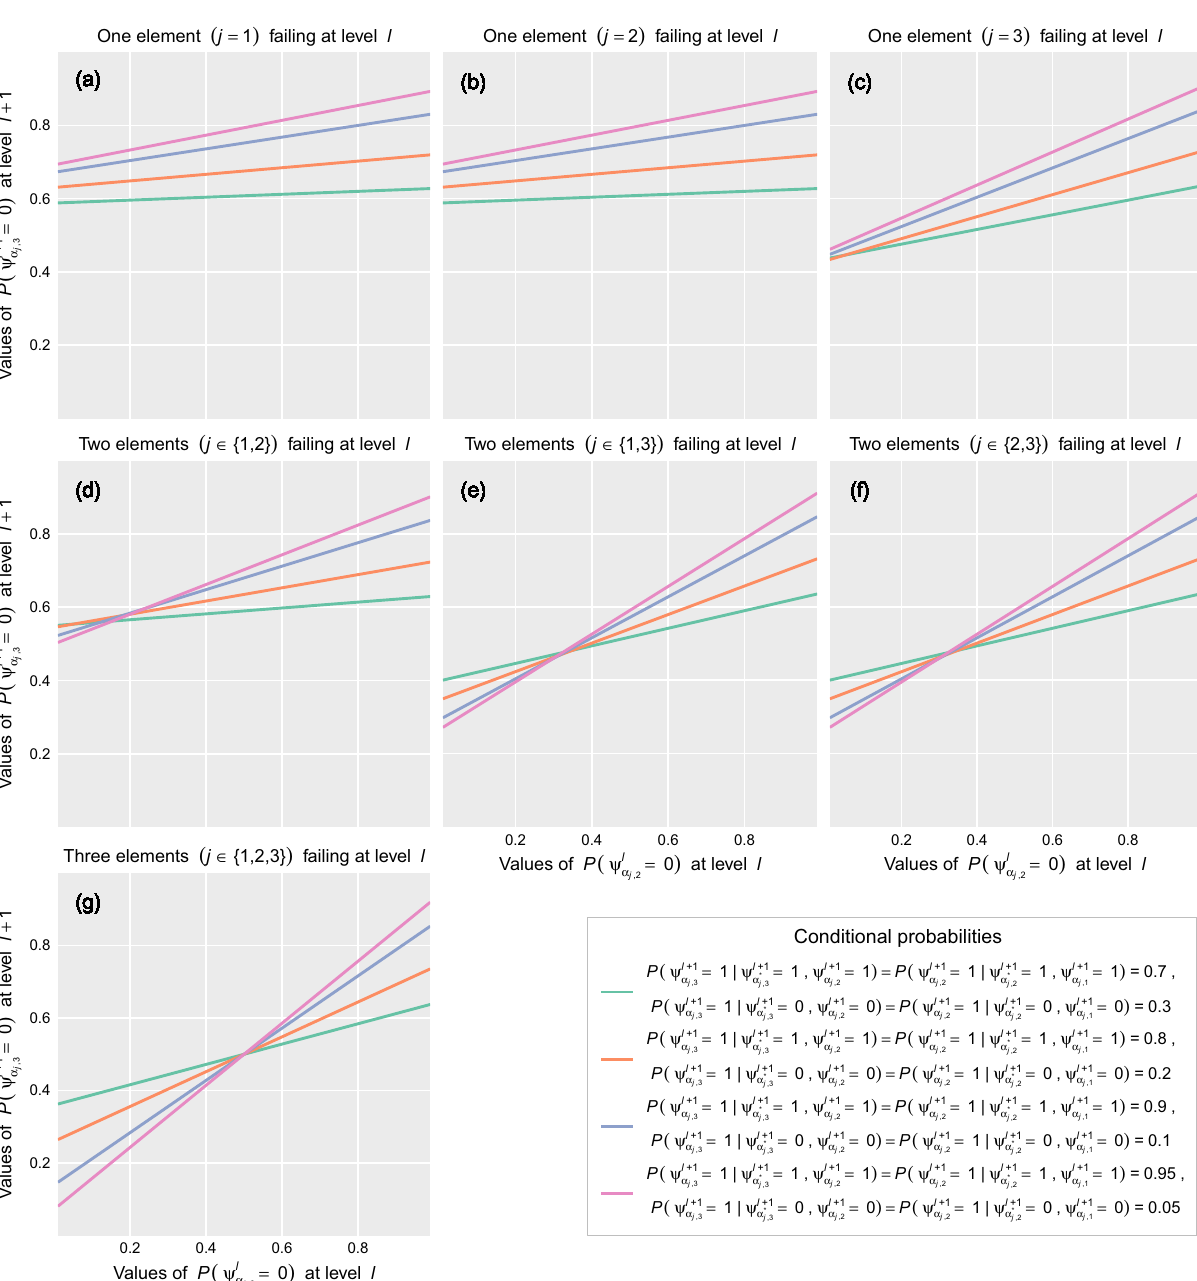
Figure 4. Performance loss of the system at level l + 1 for different failure behaviors at level l , different 1 , � l + 1 = 1 | (� l + 1 ) = ( a , b )) , where ( a , b ) ∈ { ( 1, 1 ) , ( 0, 0 ) } , and combinations of P (� l + α j , i α j , i − 1 α ∗ j , i , � l + 1 , � l + 1 = 1 | (� l + 1 = 1 | (� l + 1 ) = ( 1, 0 )) = P (� l + 1 ) = ( 0, 1 )) = 0.5 . First approach. P (� l + 1 α α j , i α j , i − 1 α j , i − 1 α ∗ j , i α ∗ j , i j , i Equivalent Bayesian